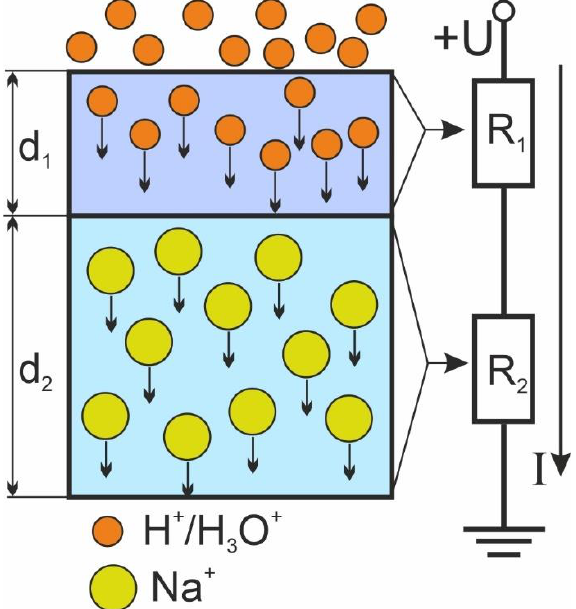
Figure 5. Schematic illustration of the poling process ( left ) and equivalent circuit ( right ). The poling illustration is not to actual scale.